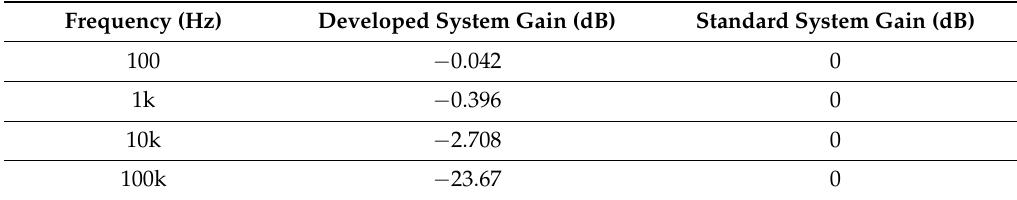
Figure 8. Frequency response of the developed measurement system.